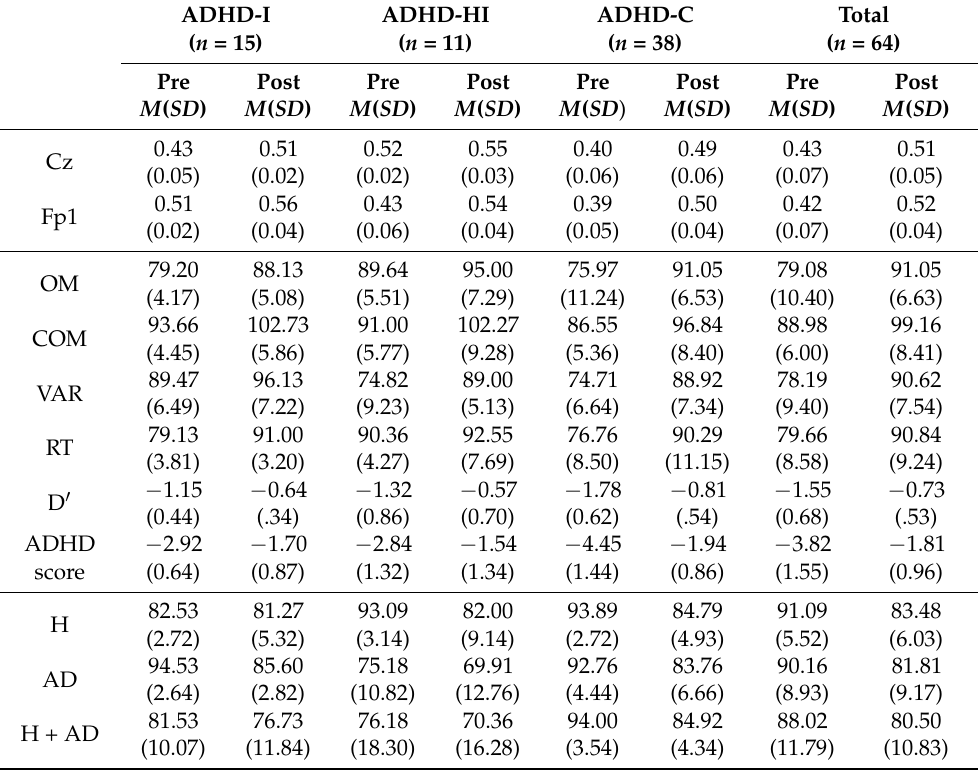
Table 2. Pre- and Post-treatment means and standard deviations for cortical activation, execution, and